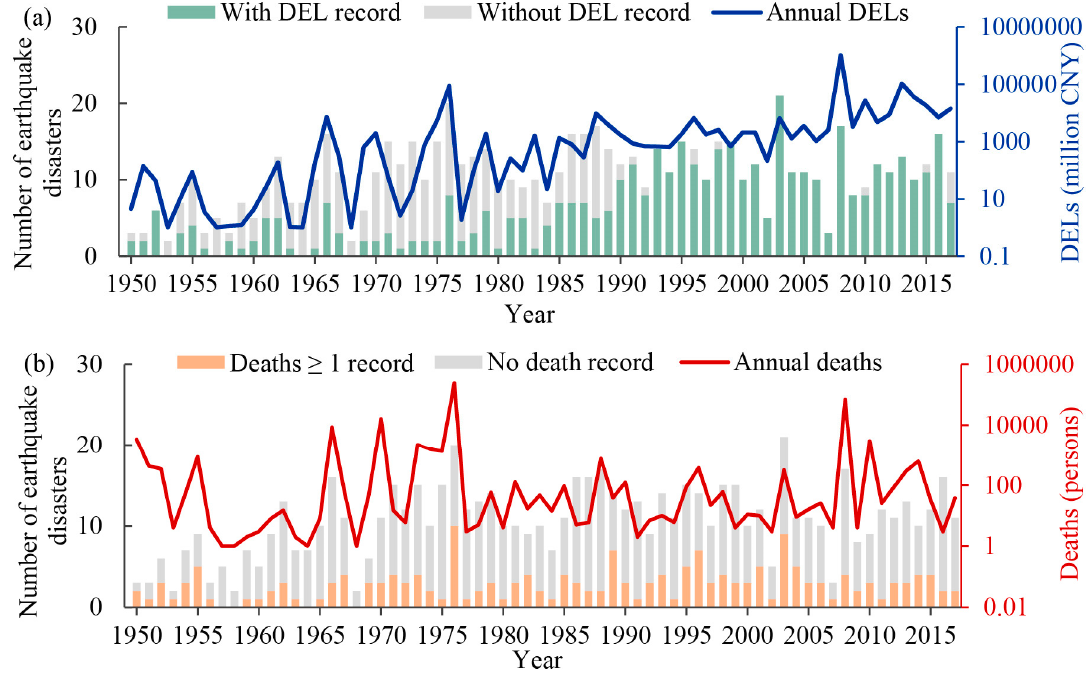
Figure 1. Annual variations in earthquake disaster numbers and earthquake-induced direct economic losses (DELs) ( a ) and deaths ( b ) over the period 1950–2017. Secondary y axes in the figure are on a logarithmic scale (note that a value of 1 has been added to the DELs and death values to avoid a value of zero).